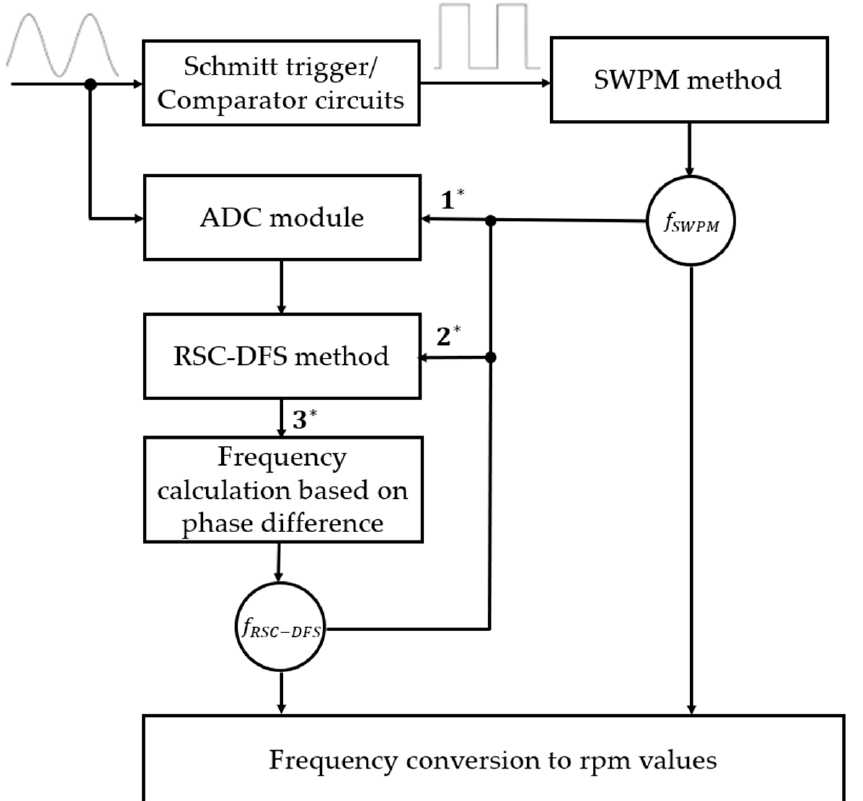
Figure 1. Schematic diagram of the low-speed measuring principle. (1*: Set the ADC sampling frequency on the basis of the frequency value. 2*: Determine the significant parameter N DFS of the DFS algorithm. 3*: Phase values at two adjacent sampling points, i.e., Φ i and Φ i + 1 with i ≥ N DFS